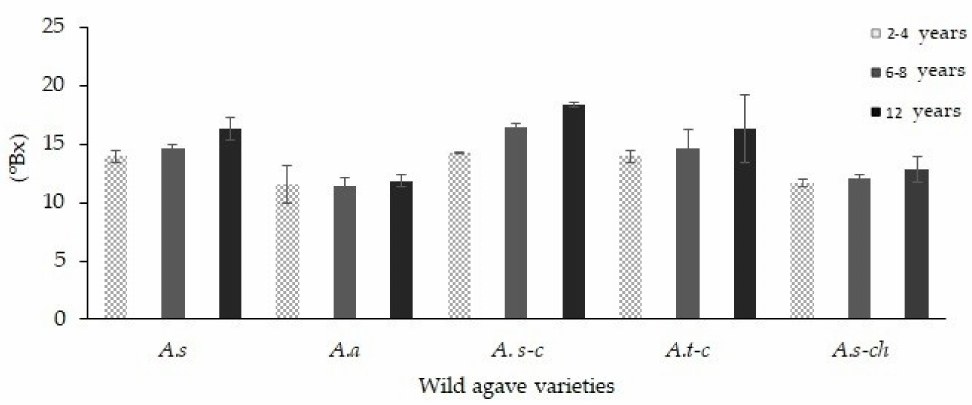
Figure 1. ◦ Brix in the fructan extracts of five wild agave varieties at di ff erent